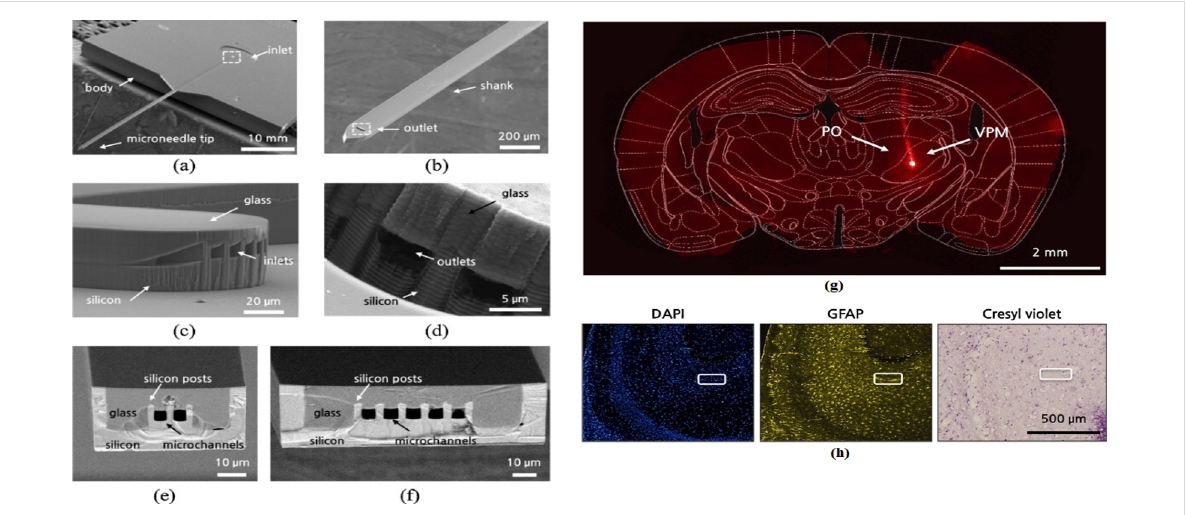
Figure 3: Scanning electron microscopy (SEM) image of a 5.3 mm long silicon microneedle fabricated by GCoS. (a) Overview, (b) microneedle outlet and shank, (c) inlet with microchannels, (d) outlet with microchannels, (e,f) cross-section of microchannels with two and five cavities. (g) A coronal brain cross-section micrograph with the infusion of a dye at the posterior nucleus, (h) a horizontal cross-section of brain displaying cells (Hoechst staining), astrocytes (GFAP staining), and neurons (cresyl violet staining) at the insertion location of the microneedle [66]. Figure 3a–h were reprinted from [66], Sensors and Actuators B, Chemical, vol. 209, by Lee, H. J.; Son, Y.; Kim, D.; Kim, Y. K.; Choi, N.; Yoon, E.-S.; Cho, I.-J., “A new thin silicon microneedle with an embedded microchannel for deep brain drug infusion”, pages 413–422, Copyright Elsevier (2014), with permission from Elsevier. This content is not subject to CC BY